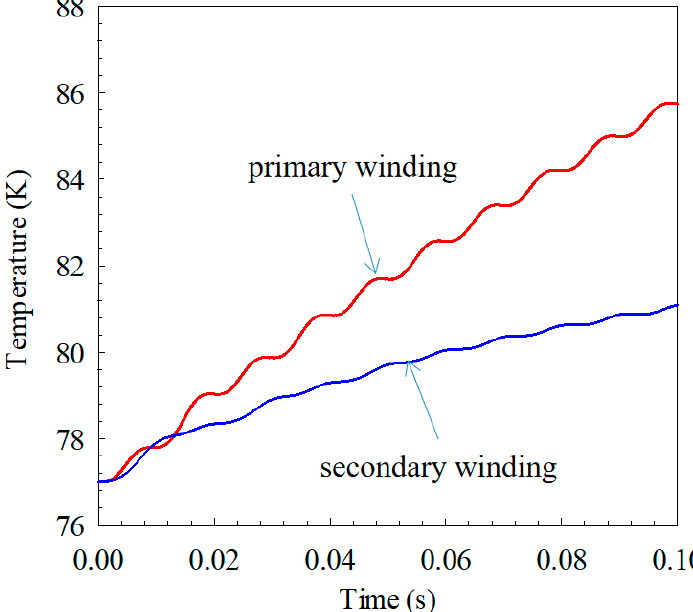
Figure 10. Rising temperature of primary and secondary windings under voltage magnitude of 30 V.